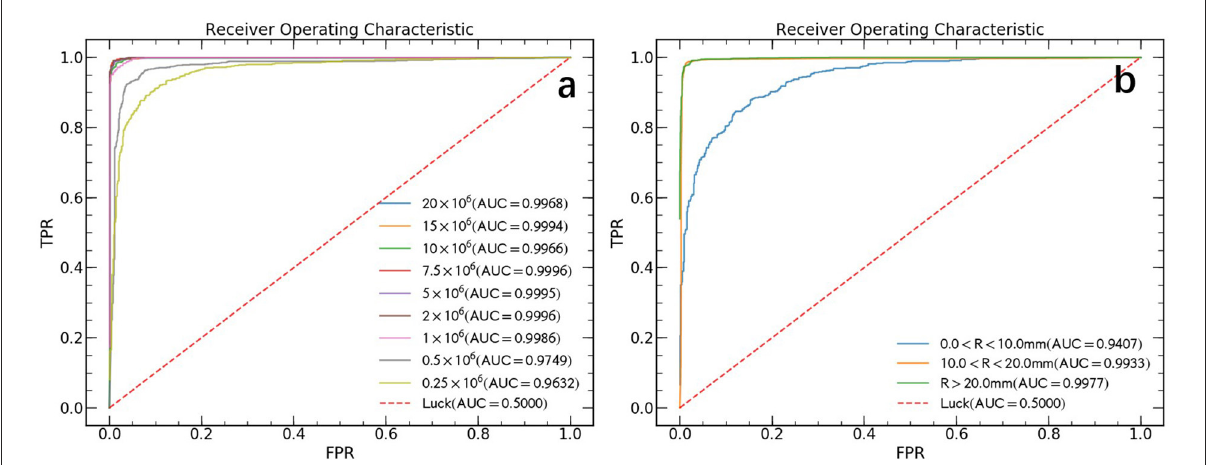
FIGURE3 ROC curves in the test data set. (a) The ROC curves of different count levels. FPR and TPR refer to false positive rate and true positive rate, respectively. (b) The ROC curves for lesions of different sizes without distinguish between count levels. Where R represents the effective diameter of lesion and calculate by converting the lesion area to diameter of the circle.